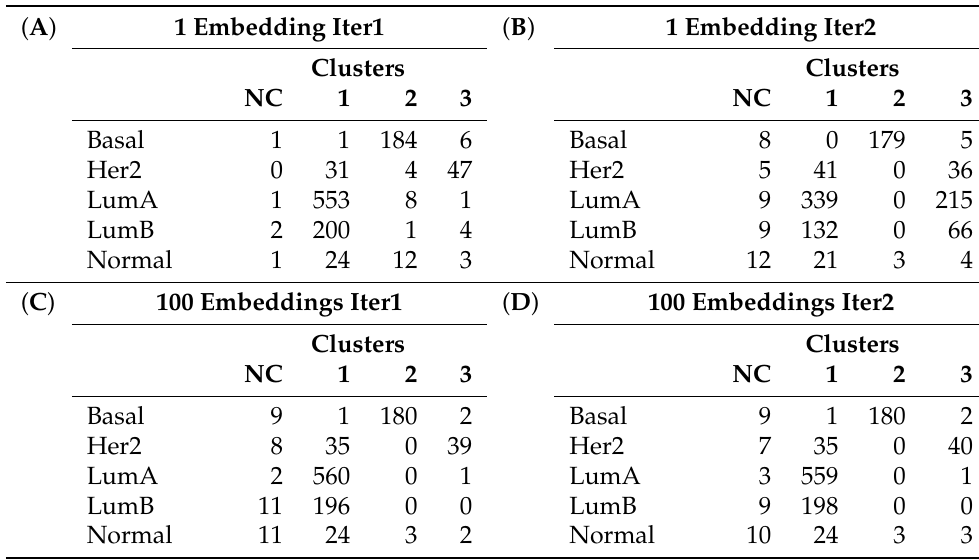
Table A1. Joint frequencies of cluster outputs and BC subtypes related to two separate UMAP runs (top tables: A and B), and two independent runs of our proposed procedure with T = 100 (bottom tables: C and D).